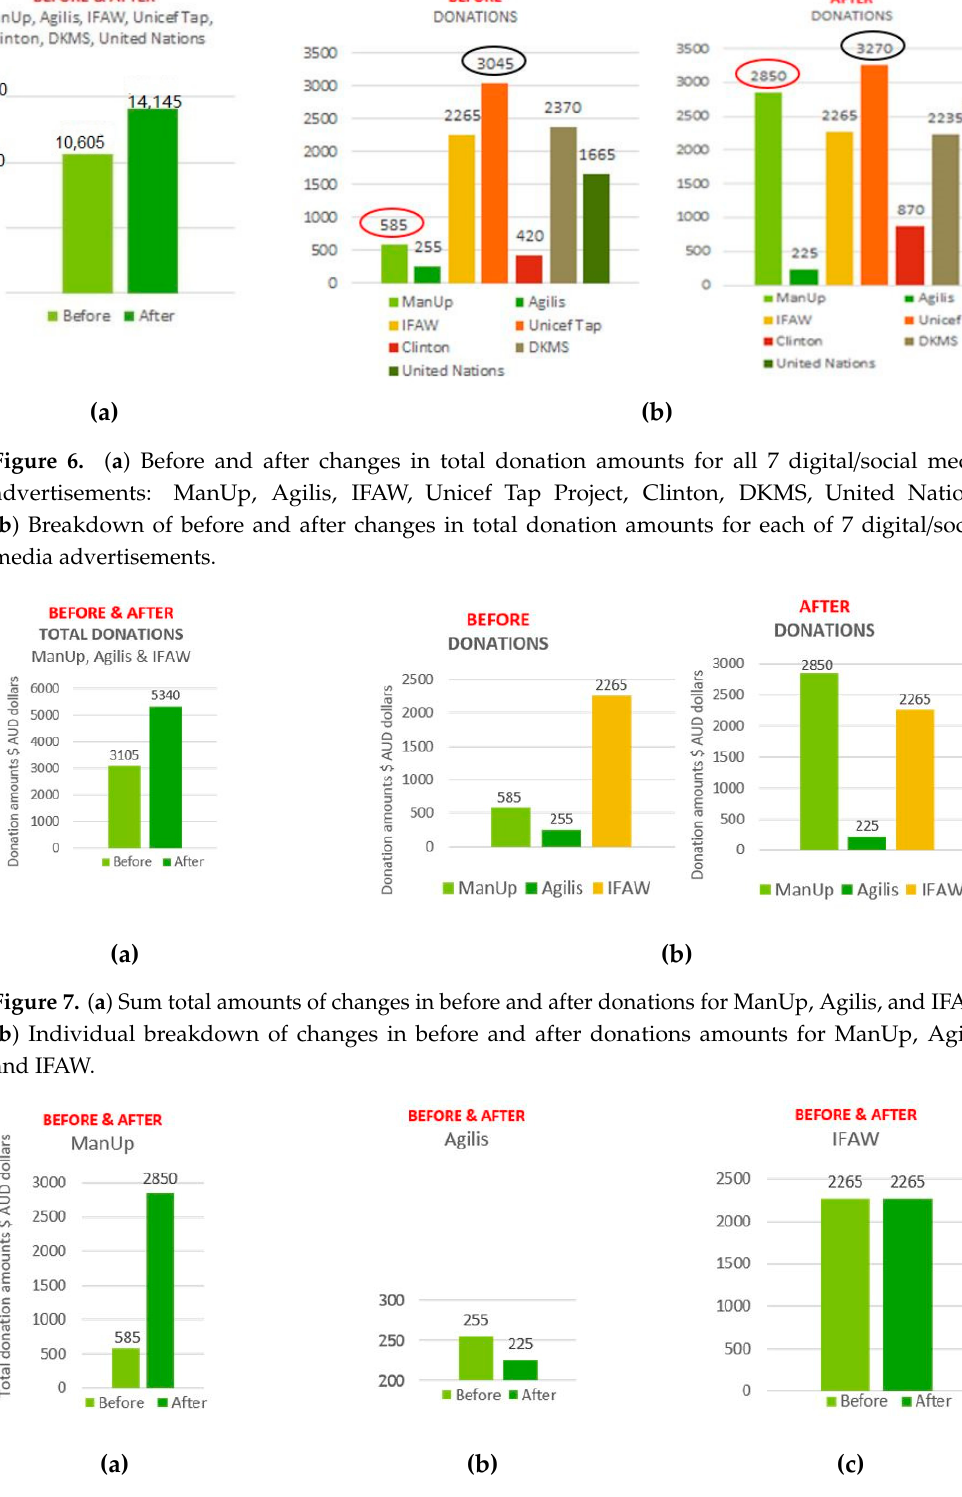
Figure 8. Before and after changes in donation amounts for ( a ) ManUp; ( b ) Agilis; and ( c ) IFAW. Two-tailed t-tests were conducted in SPSS for each advertisement comparing changes in donations made. The largest decrease in mean was for ManUp (0.987), with the smallest increase in mean for DKMS ( − 0.059), followed by Agilis (control) ( − 0.015), while IFAW showed no change (0.000) (Table